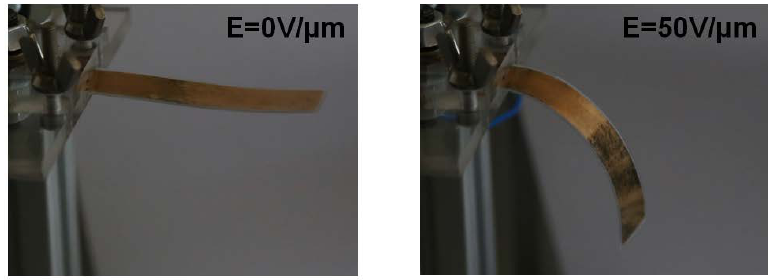
Figure 9. Photo of the unimorph under different input electric field values.